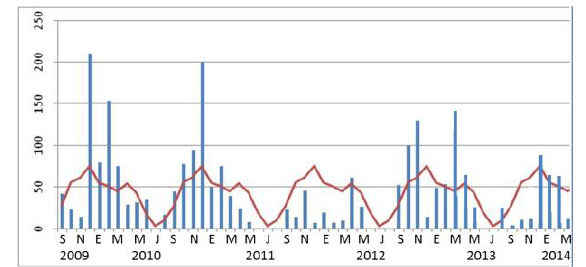
Figure 8. Rainfalls at the station of the University of Jaén, next to the studied